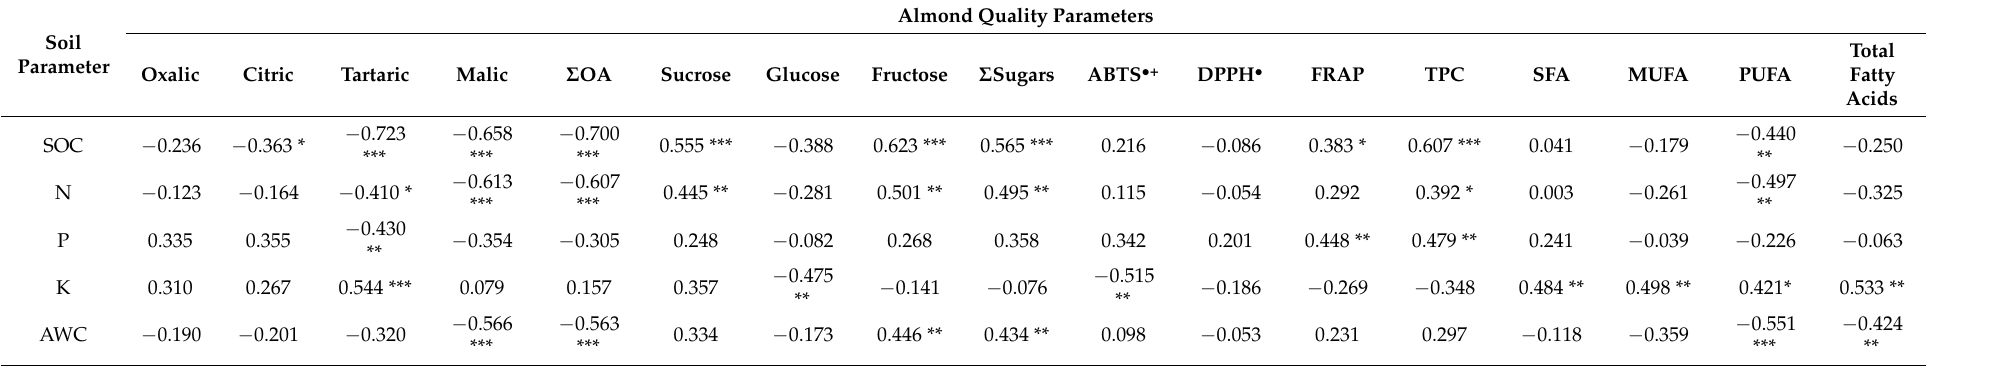
Table 10. Relationships among selected soil properties and almond quality